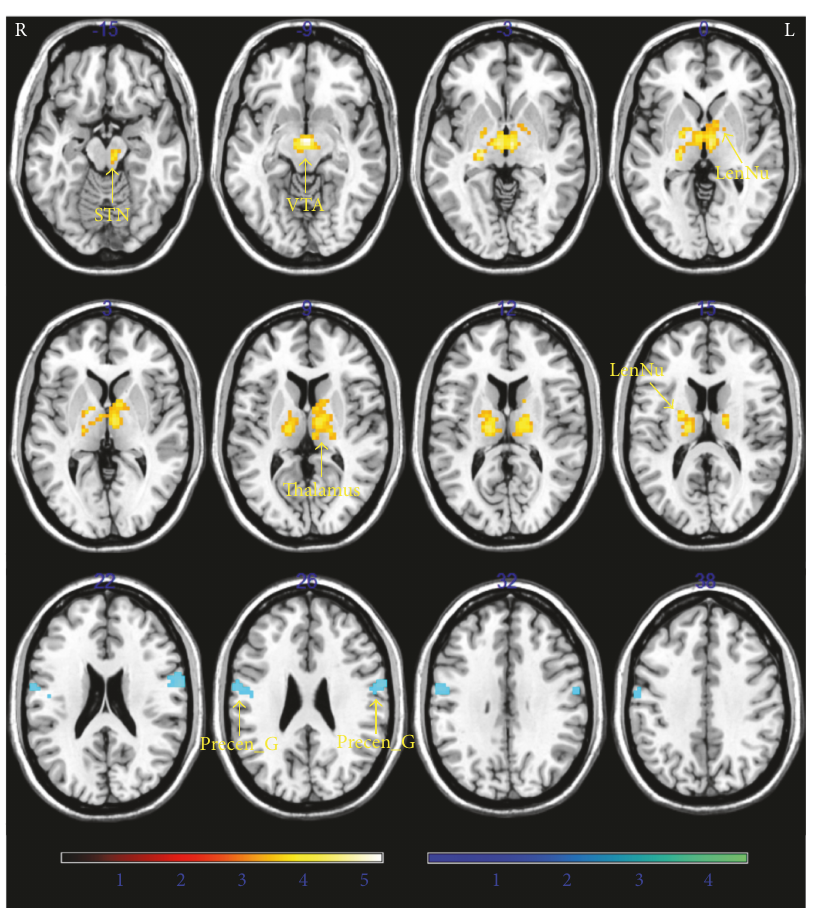
Figure 2: Brain mapping of functional connectivity with PCC/precuneus demonstrates a signi fi cant association with mean scores of negative and positive urgency ( P FWE = 0 05 , family-wise error correction). The hot color indicates a positive correlation with mean scores of negative and positive urgency; the cool color indicates a negative correlation with mean scores of negative and positive urgency. STN: substantia nigra; VTA: ventral tegmental areas; LenNu: lentiform nucleus; Precen_G: precentral